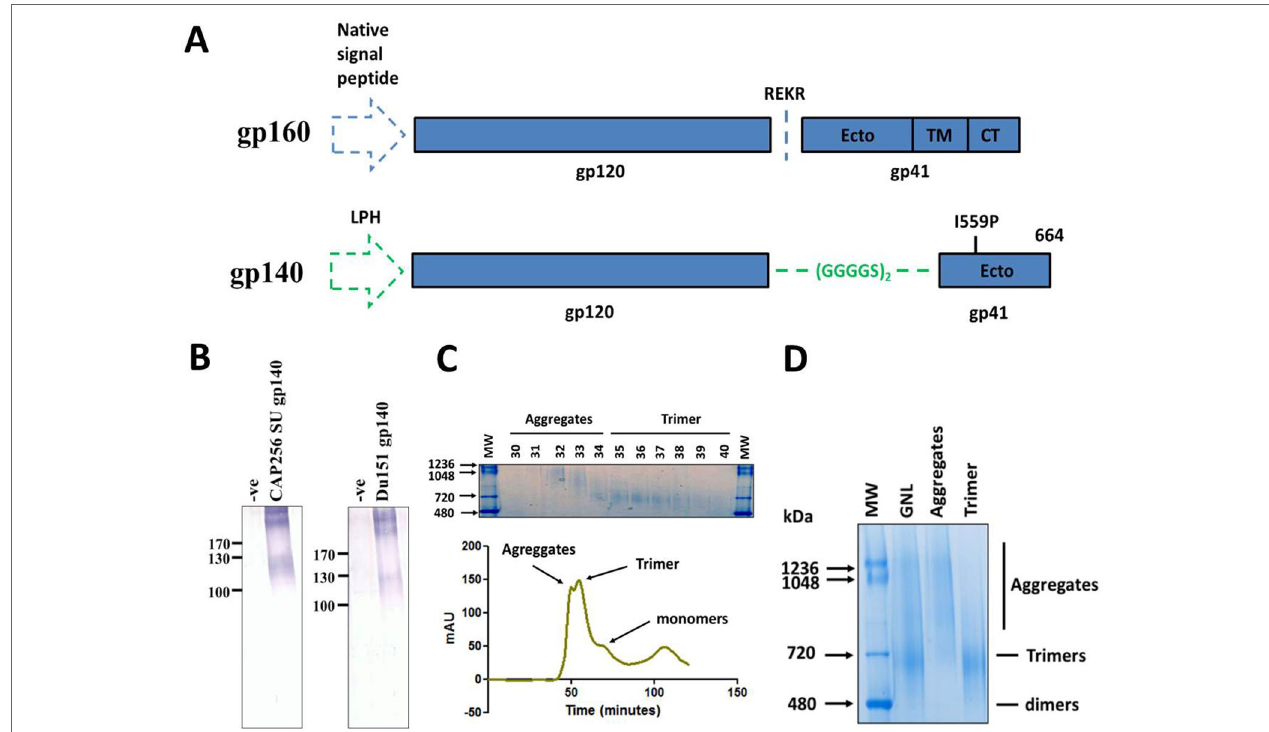
FIgUrE 1 | Design, expression and purification of HIV Env gp140 antigens. (A) Schematic of the coding sequence for the native HIV-1 gp160 gene (top) and the soluble gp140 antigen (bottom). The gp120 and gp41 portions of the proteins are delineated with either the native cleavage sequence (REKR) or flexible linker peptide (GGGGS) 2 at the interface of the two subunits. The location of the I559P helix breaking mutation and amino acid residue 664, where the coding sequence was terminated, is reflected for the gp140 antigen. The native and LPH (leader peptide heavy chain) signal sequences are shown by the blue and green dashed arrows respectively. (Ecto = ectodomain, TM = transmembrane, CT = cytoplasmic tail). (B) Western blot confirming expression of CAP256 SU gp140 (left) and Du151 gp140 (right) in crude leaf homogenate, 5 days post infiltration. Blots were probed with polyclonal goat anti-HIV-1 gp120 antibody. The negative controls comprise of leaf tissue agroinfiltrated with recombinant A. tumefaciens AGL1 that has been transformed with the empty pEAQ-HT expression vector (-ve). Both CAP256 SU Env and Du151 Env contain 29 putative N-glycosylation sites. (C) Superdex 200 Hiload 16/600 elution profile of fractionated CAP256 SU Env species following affinity chromatography. The identities of the different protein species are indicated on the profile. A Coomassie-stained BN-PAGE gel of the fractionated material is shown above the graph indicating the fractions that comprise the aggregates and presumed trimer peaks. (D) Coomassie stained BN-PAGE gel containing the pooled and concentrated CAP256 SU Env samples corresponding to peaks in the elution profile peaks. An aliquot of the affinity-purified protein (GNL), prior to SEC, was resolved alongside aggregate and trimer samples for comparison. The trimers indicated in both panels (C) and (D) are based on the SEC elution profiles and BN-PAGE migration of other HIV-1 gp140 antigens in the published